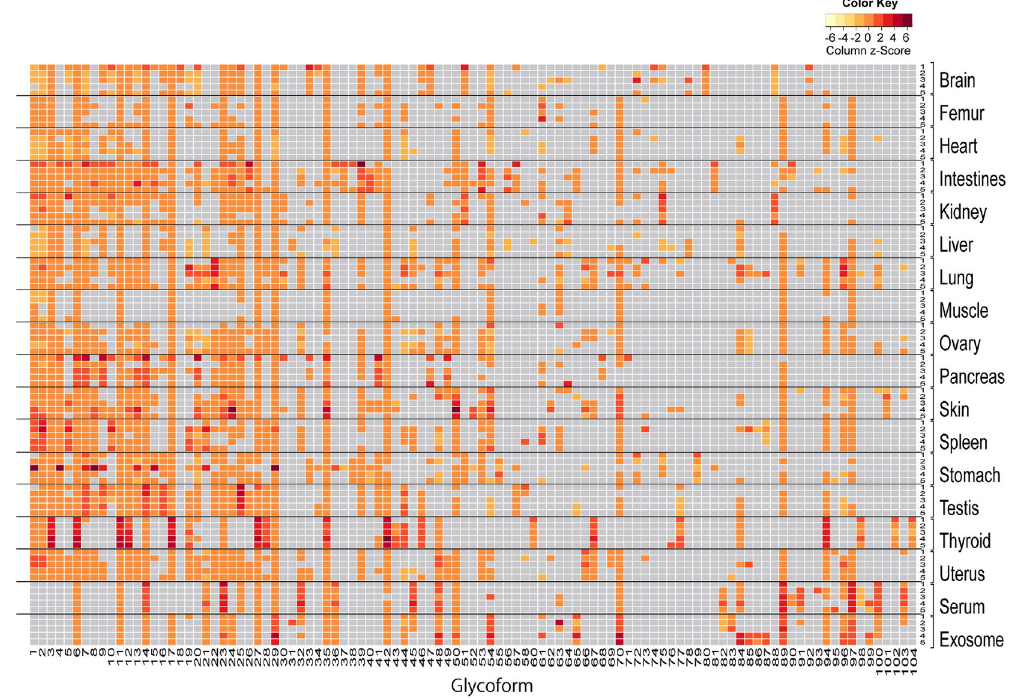
Figure 4. Heatmap representation of the scaled expression levels of N -glycan structures shown in Fig. 2 (103 glycoforms listed in Fig. S2) identified in the mouse organs/tissues, serum, and serum-derived exosomes. The color key in the heatmap shows the column z-score of level for each glycoform. The grey rectangles show that the peaks are not detected. The numbers of 1–5 in a right column show the sample number for each organ/ tissue, serum, and exosomes described in the Table S2. The numbers of 1 – 104 (compound 59 as an internal standard is not shown) in a bottom row represent the glycoforms listed in Table S1 and Fig. S2,